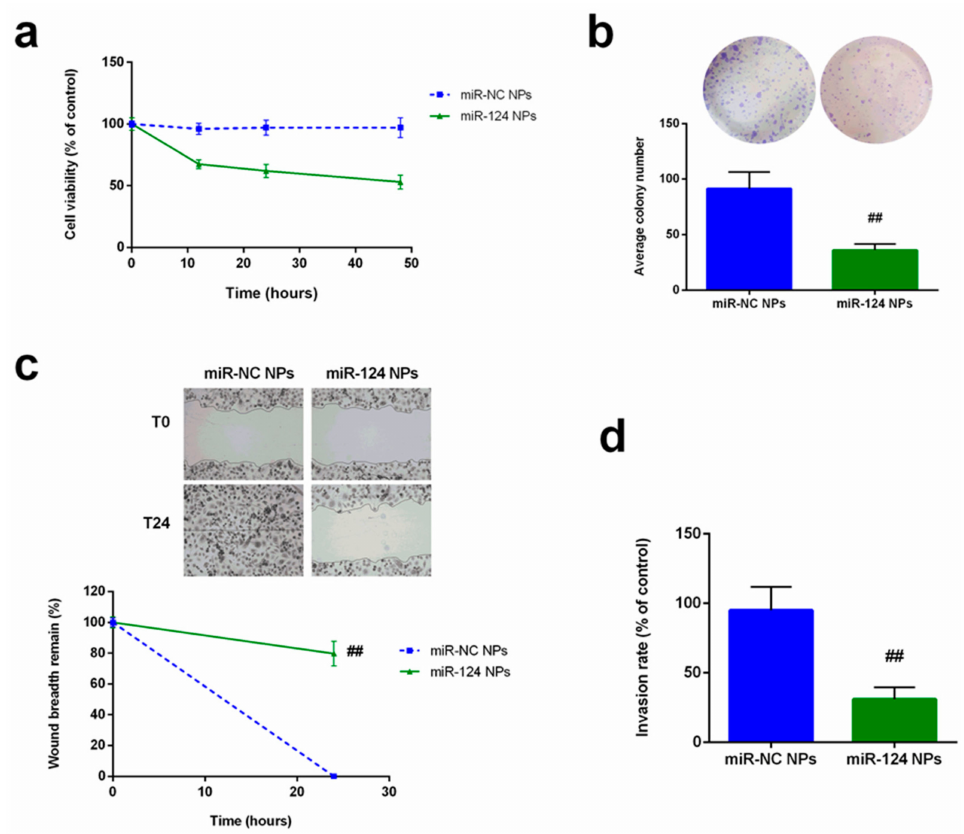
Figure 5. Influence of forced expression of miR-124 on PC3 proliferation, migration, and invasion. ( a ) Cell proliferation of PC3 cells was determined by CCK8 assay after 12, 24, and 48 h. ( b ) Colony formation assay was performed after 14 days of culture. For quantification, colonies with at least 50 cells were considered. Representative micrographs were obtained using phase contrast microscope after staining with crystal violet. ( c ) Wound-healing assay performed on transfected PC3 cell, and wound closure rate measured by detecting the closure distance after 24 h. Representative micrographs of the cell migration (top) and quantification (bottom) from three independent experiments are presented. ( d ) Transwell invasion assay with Matrigel performed in miR-124-NPs or miR-NC-NPs-transfected PC3 cells after 24 h. Five random fields in each well were counted under a microscope. The bars represent the mean ± SD, n = 3. Statistically significant variations: ## p < 0.01, miRNA versus